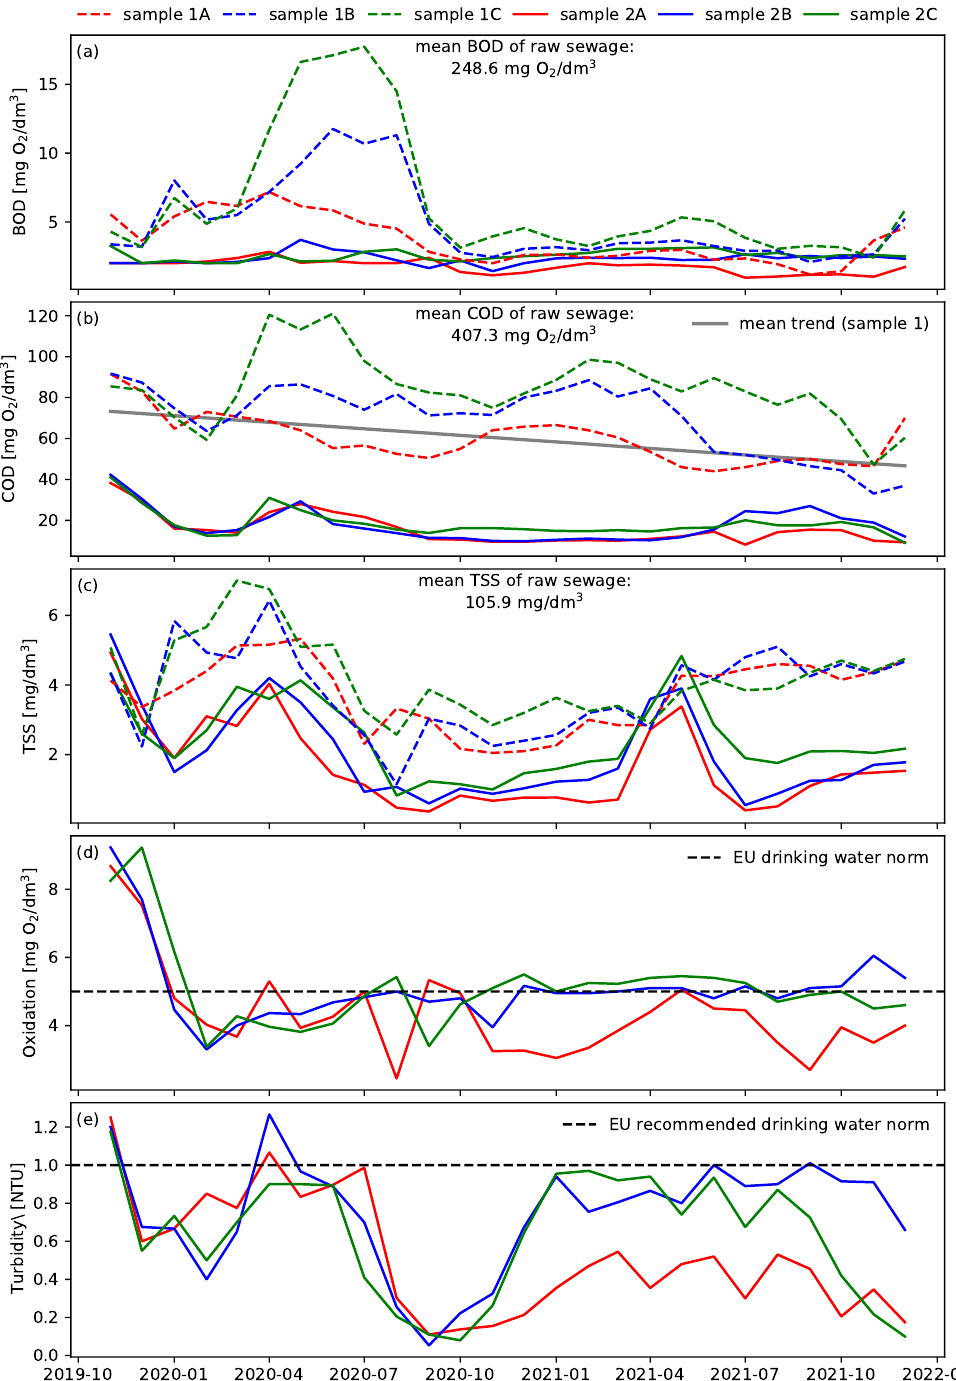
Figure 3. Quality of the water purified with the daily flow of 70 (A), 100 (B), and 130 l/m 2 (C), sampled after the compost bed (sample 1) and after the active carbon bed (sample 2). The following indicators are presented: ( a ) biological oxygen demand (BOD), ( b ) chemical oxygen demand (COD), ( c ) total suspended solids (TSS), ( d ) oxidation, and ( e ) turbidity (nephelometric turbidity unit—NTU). The drinking water quality recommendation is taken from the European Council Directive